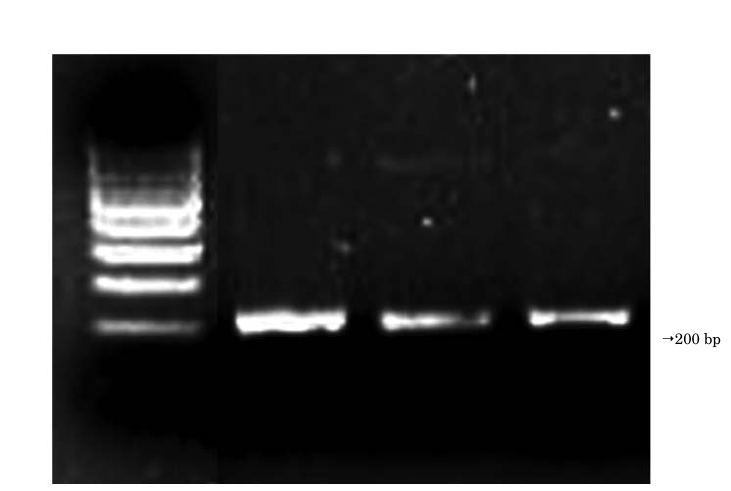
Fig. 1. Laccase gene ampli fi cation. Lane 1, 100 bp ladder; lane 2, SV; lane 3, CRS-1; lane 4, SLP.